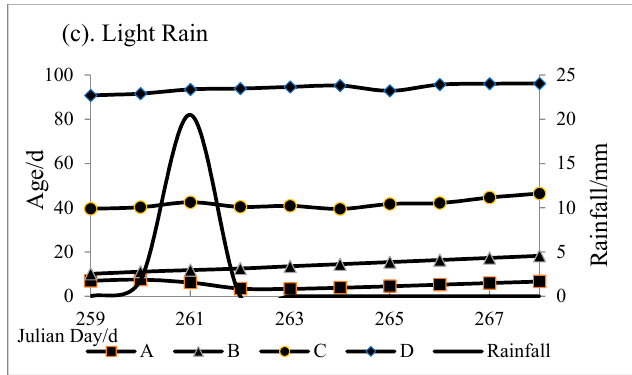
Figure 9. Water ages at the point C (shown in Figure 1) and rainfall: ( a ) a heavy rain; ( b ) a moderate rain; ( c ) a light rain.